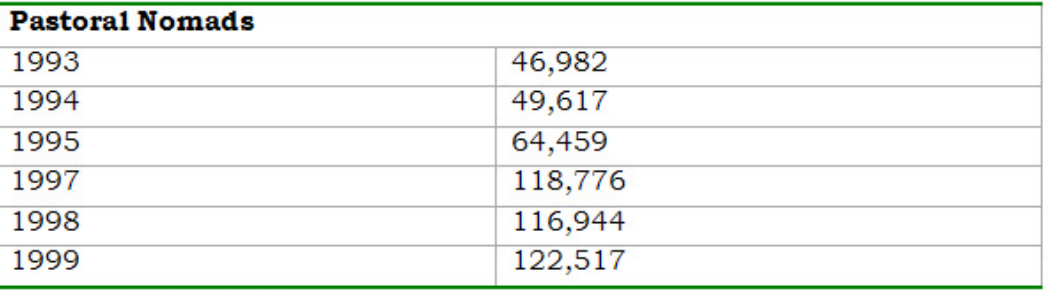
Table 1. Enrolment of Pastoral Nomads in the 1990s